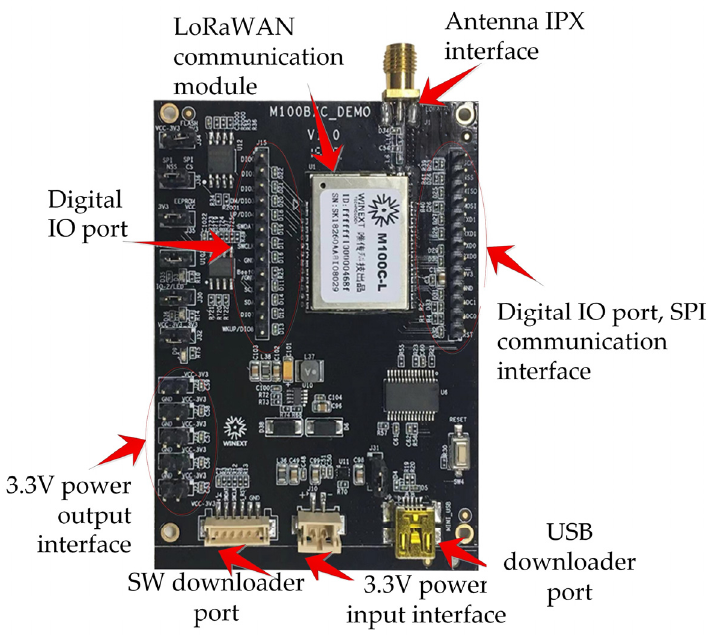
Figure 19. The LoRaWAN gateway hardware.